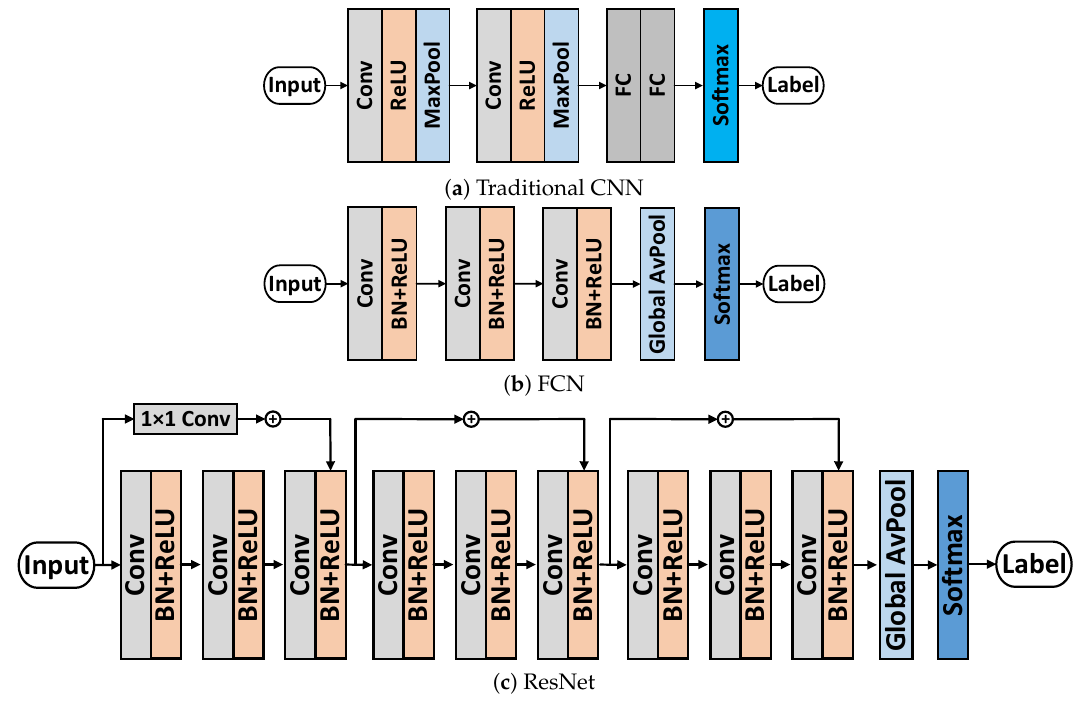
Figure 7. The architectures of network classifiers used in this